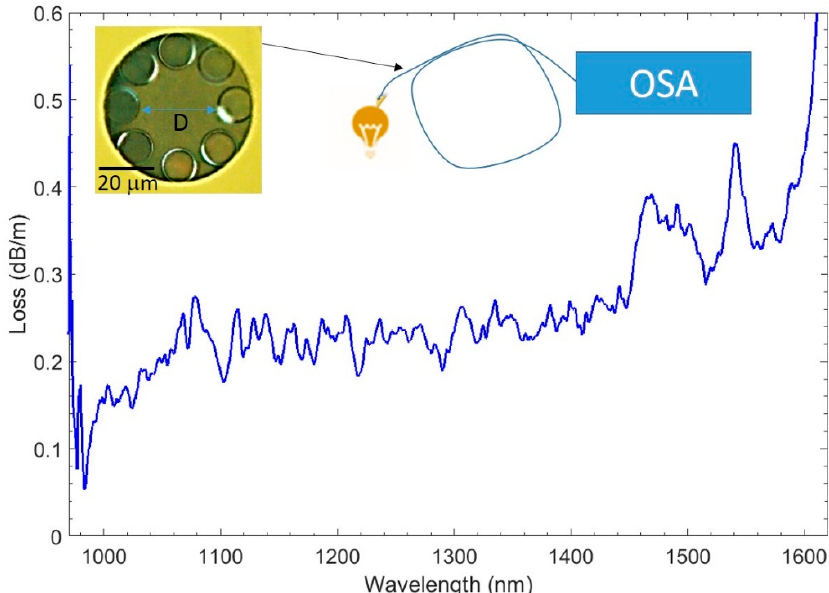
Figure 2. Attenuation of a borosilicate based hollow-core optical fiber (shown in the inset on the left-hand side). On the right-hand side is a sketch of the measurement setup including only an incoherent optical source, a loosely cooled fiber, and an optical spectrum analyzer (OSA). Fiber loss is just above 0.2 dB/m over a 400 nm wide spectral bandwidth.